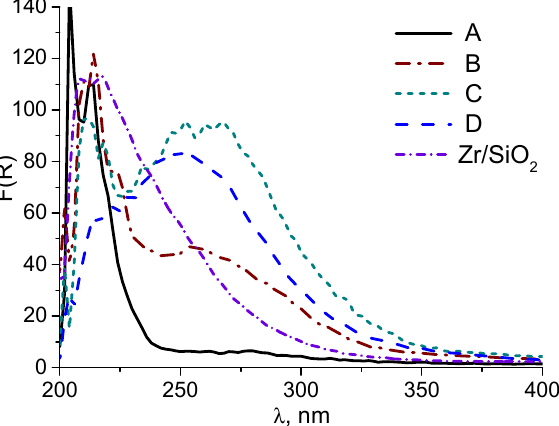
Figure 3. DR UV–vis spectra of Zr-MMM-E (samples A – D ) and Zr/SiO 2 . Raman spectroscopy was also used to investigate the nature of Zr species formed on the catalyst surface. The spectra of samples A and D are shown in Figure 4 in comparison with the spectra of the zirconium-free silicate matrix. Despite the pronounced difference observed in the DR–UV spectra, all Raman spectra look quite similar. Although the spectra are not well defined, we may conclude that ZrO 2 is present in amorphous and/or cluster- ized forms rather than in crystalline domains, as no characteristic bands typically